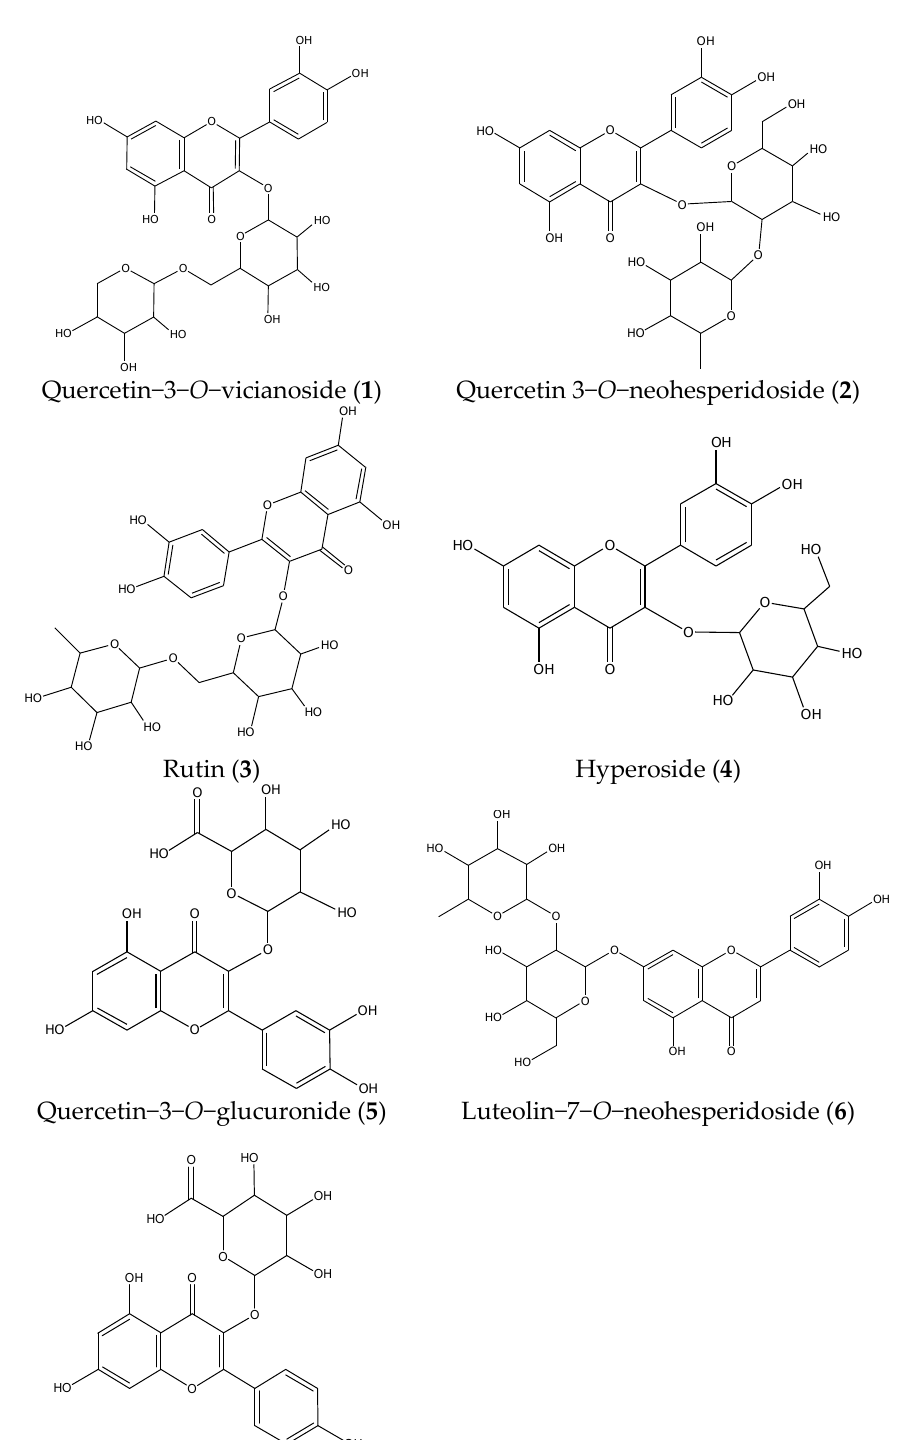
Figure 3. The chemical structures of the seven compounds.